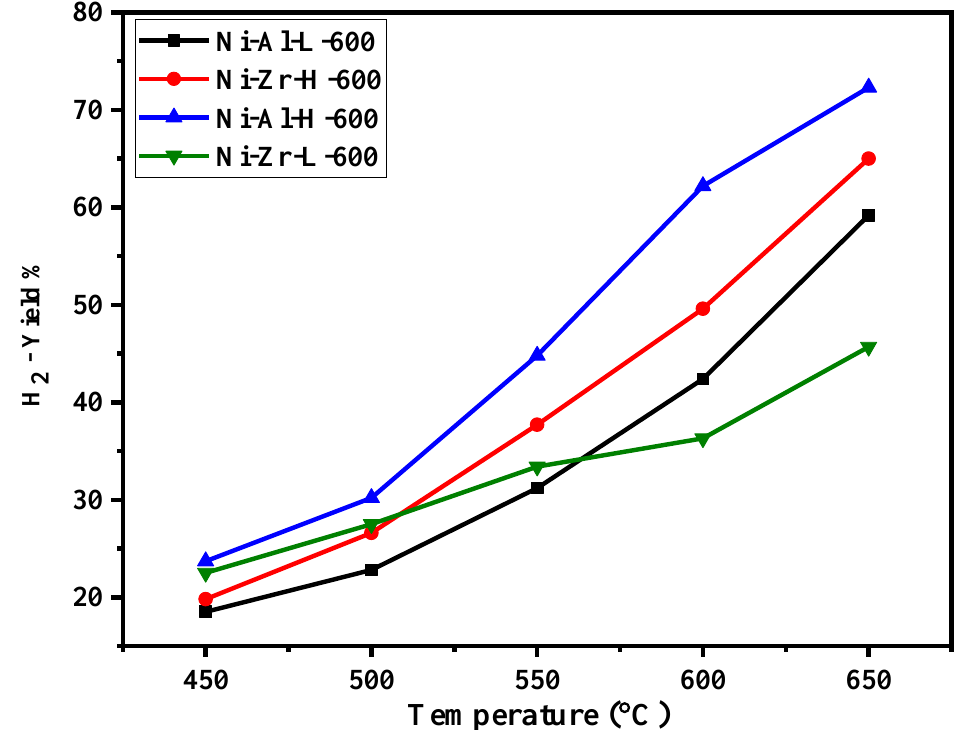
Figure 8. Catalytic activity of catalysts calcined at 600 °C: H 2 yield against reaction temperature (450–650 °C).